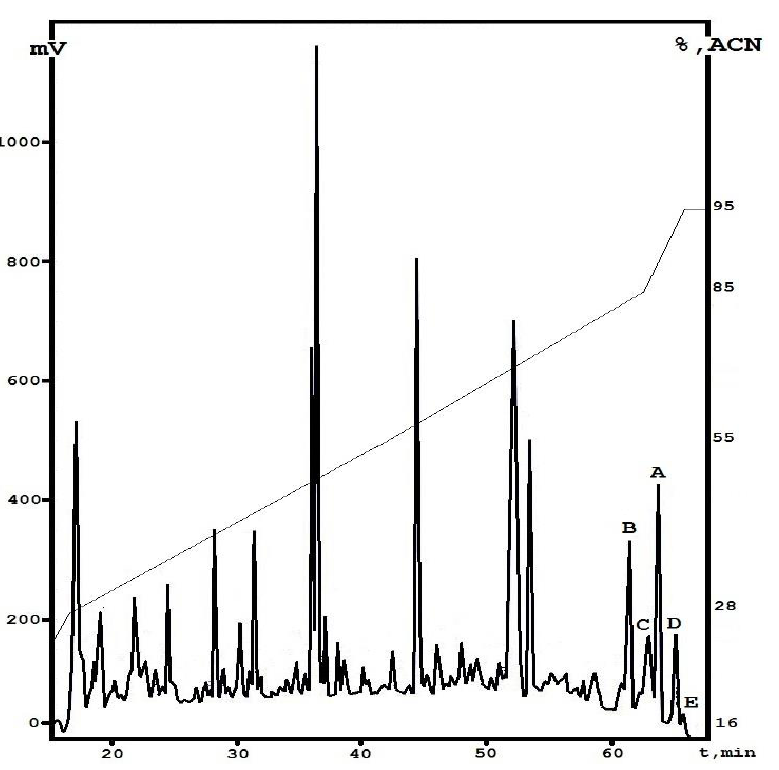
Figure 2. Fractionation of the E. alkalina concentrate by analytical reversed-phase HPLC. Detection of absorbance was monitored at 214 nm. The target components are marked by letters A‒E.